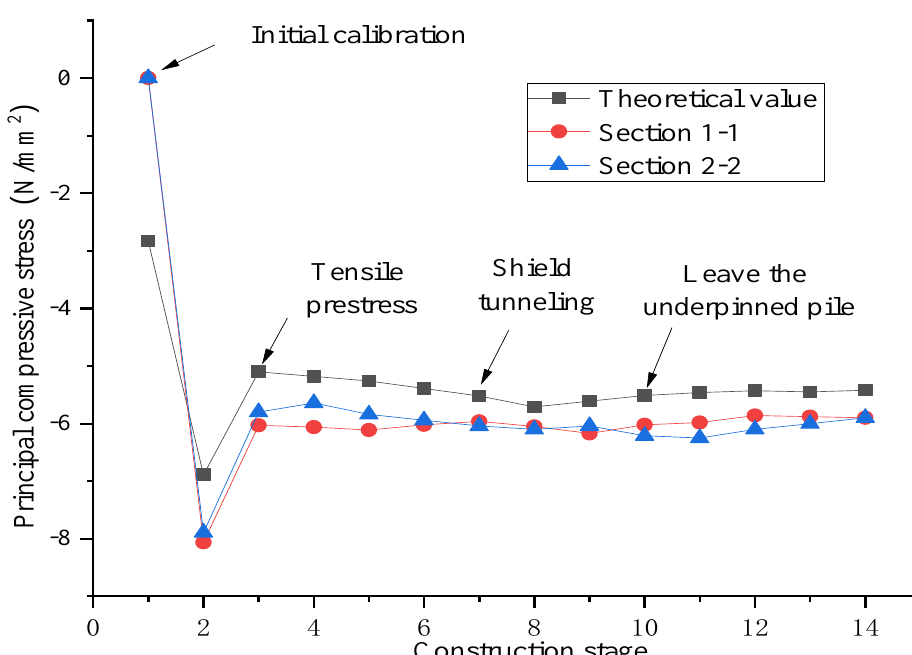
Stress monitoring data of sensors numbered Sections 3.3 and 4.4 which places in the bottom of underpinning bearing platform are presented in Figure 16. As it shown that before the steel strands are prestressed, stress in the bottom of underpinning bearing plat- form reaches the maximum −8.02 MPa. While the prestressed system is completed Sec- tions 3.3 and 4.4 stress decreases from −8.02 MPa to −6.20 MPa immediately. Furthermore, while the shield machine crosses through the foundation area there is no abnormal stress changes could be founded based on the field stress gauging data, stress of underpinning Figure 15. Tensile stress gauging results of piles foundation underpinning. Figure 15. Tensile stress gauging results of piles foundation underpinning. bearing platform is stable.